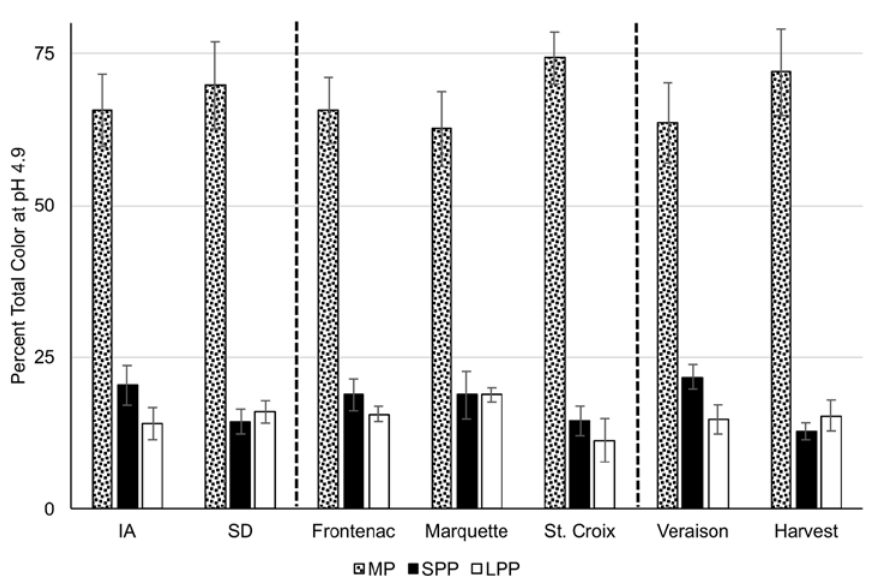
Figure 4. Comparison of the color contributed by monomeric pigments (MP) or free anthocyanins, short polymeric pigments (SPP), and long polymeric pigments (LPP) at pH 4.9 in Frontenac, Marquette, and St. Croix fruit at veraison and harvest, collected in Iowa (IA) and South Dakota (SD). Total color (100%) measured by spectrophotometer is the sum of MP, SPP, and LPP. Three panels are shown to signify (from left to right) the contribution of MP, SPP, and LPP to the total color extracted from berry skins by vineyard site (IA and SD), by cultivar (Frontenac, Marquette, and St. Croix), and by time point (veraison and harvest).